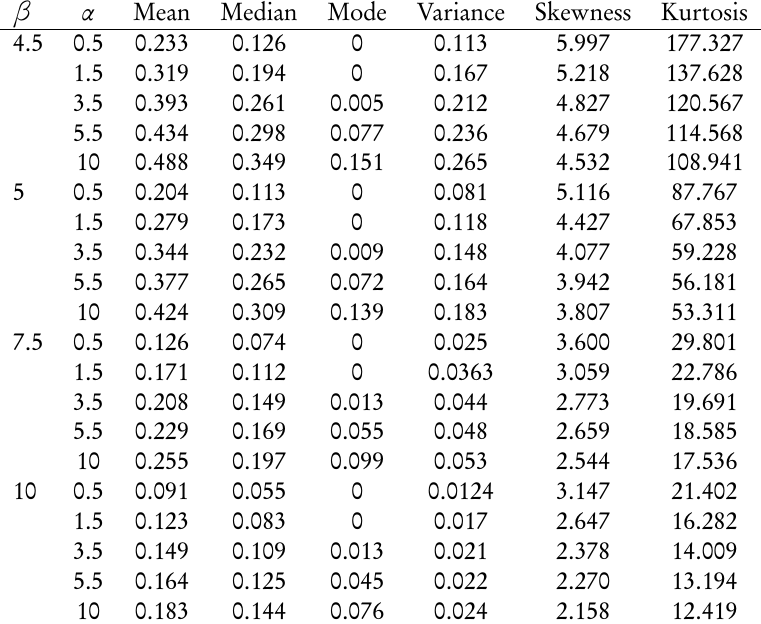
Mean, median, mode, variance, skewness, and kurtosis of APTL distribution for various values of α , β and λ = 1